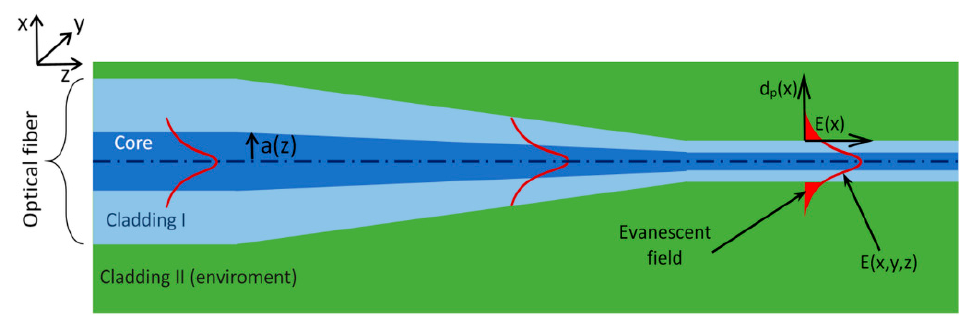
Figure 1. Propagation of light in an optical fiber taper [25,26].